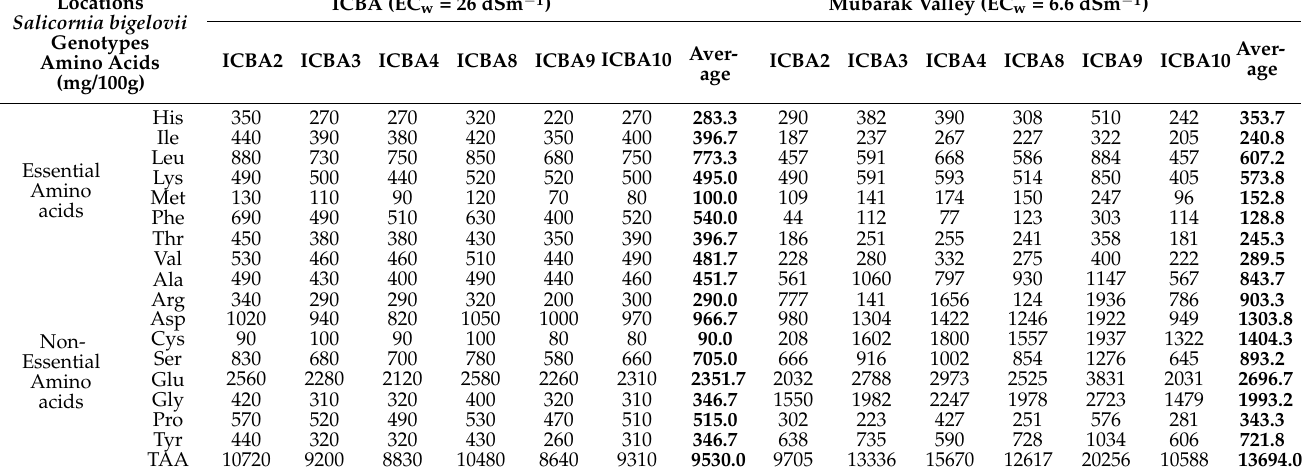
Table A4. Essential and non-essential amino acids (mg/100g) analyzed for seeds of six Salicornia bigelovii genotypes collected at the end of the growing season at ICBA’s experimental station and Mubarak Valley. The average value per parameter from all genotypes was calculated (in bold) for each location.